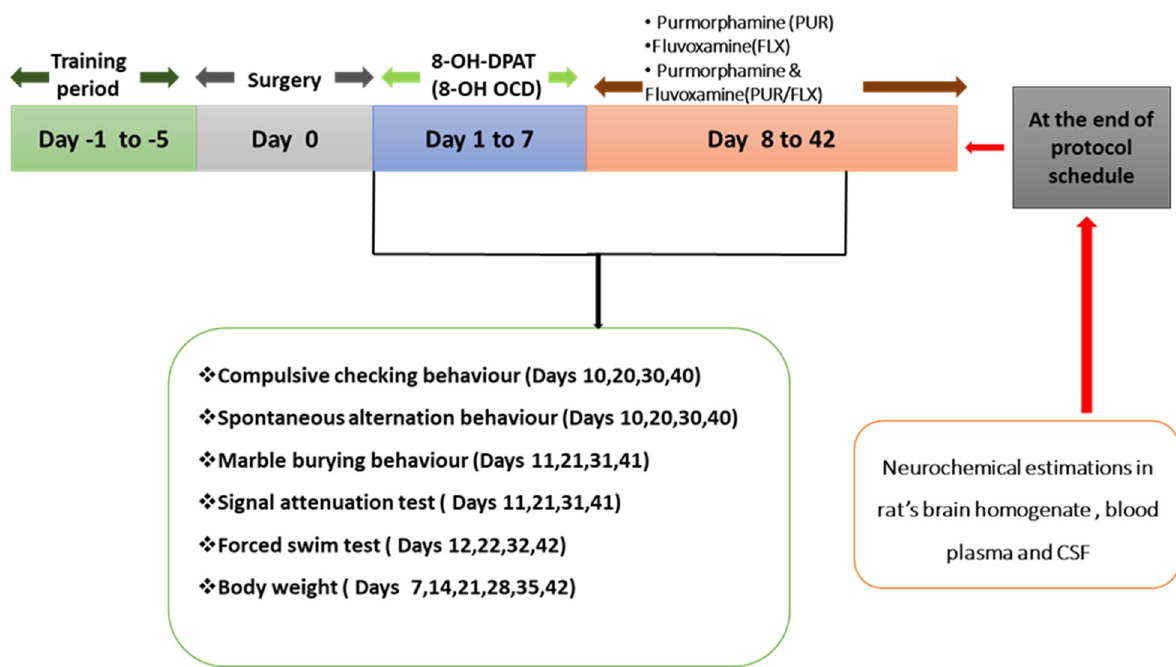
Figure 1. Experiment protocol schedule.